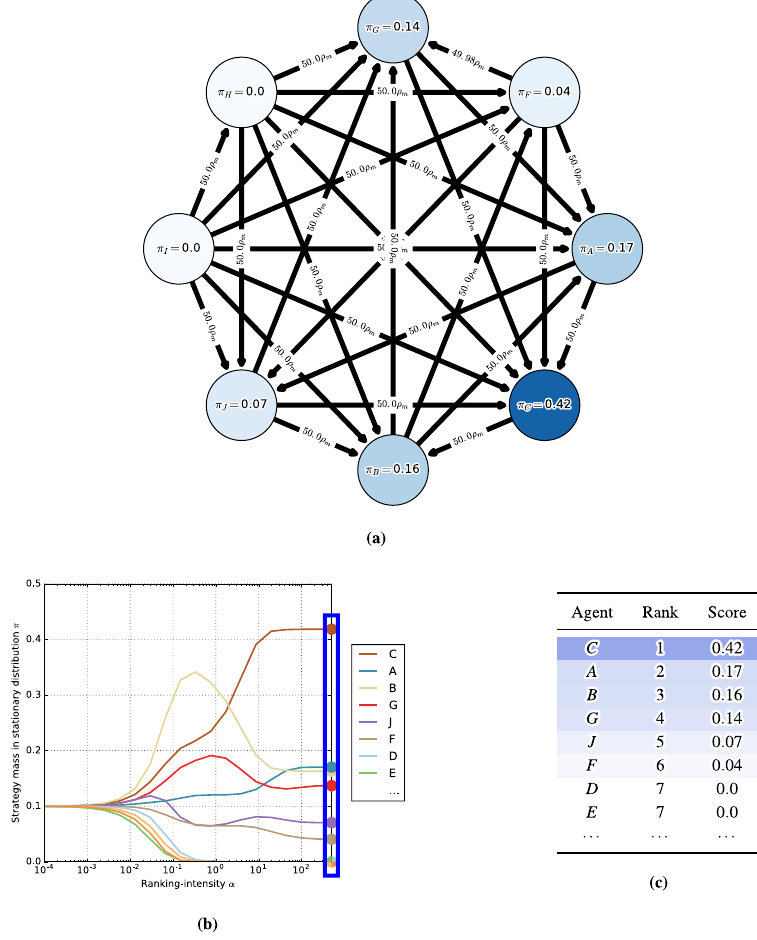
Figure 12. MuJoCo soccer dataset. ( a ) Discrete-time dynamics. ( b ) Ranking-intensity sweep. ( c ) α -Rank